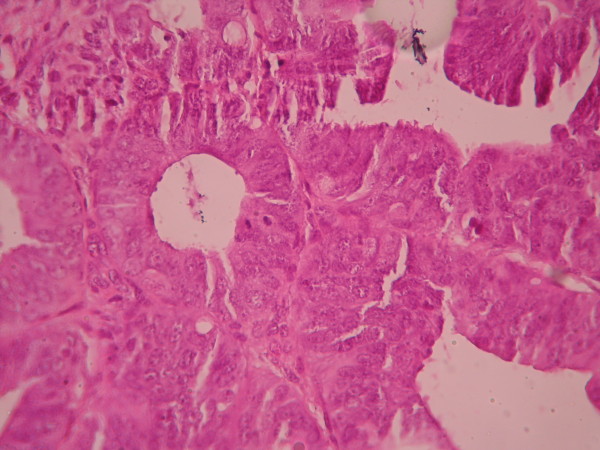
Endometrial adenocarcinoma. Confluent growth pattern of glands with no intervening endometrial stroma and severe nuclear atypia. (High power).